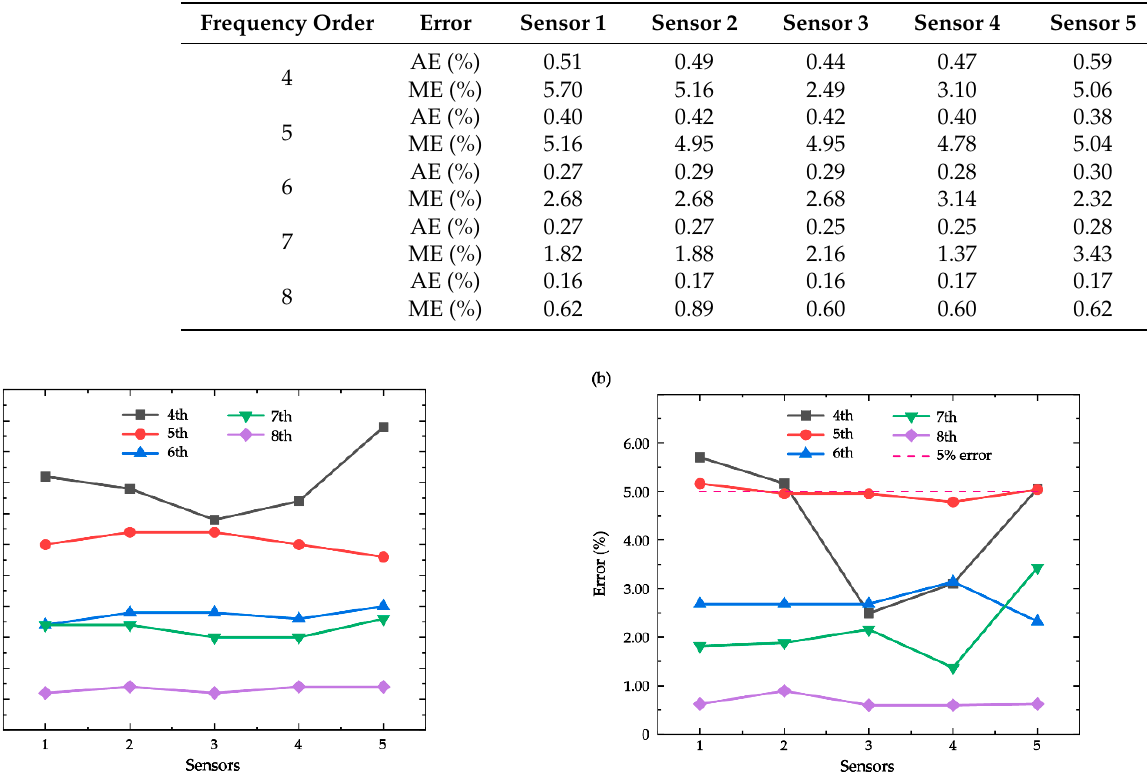
Table 2. Error of tension calculated by each order frequencies.